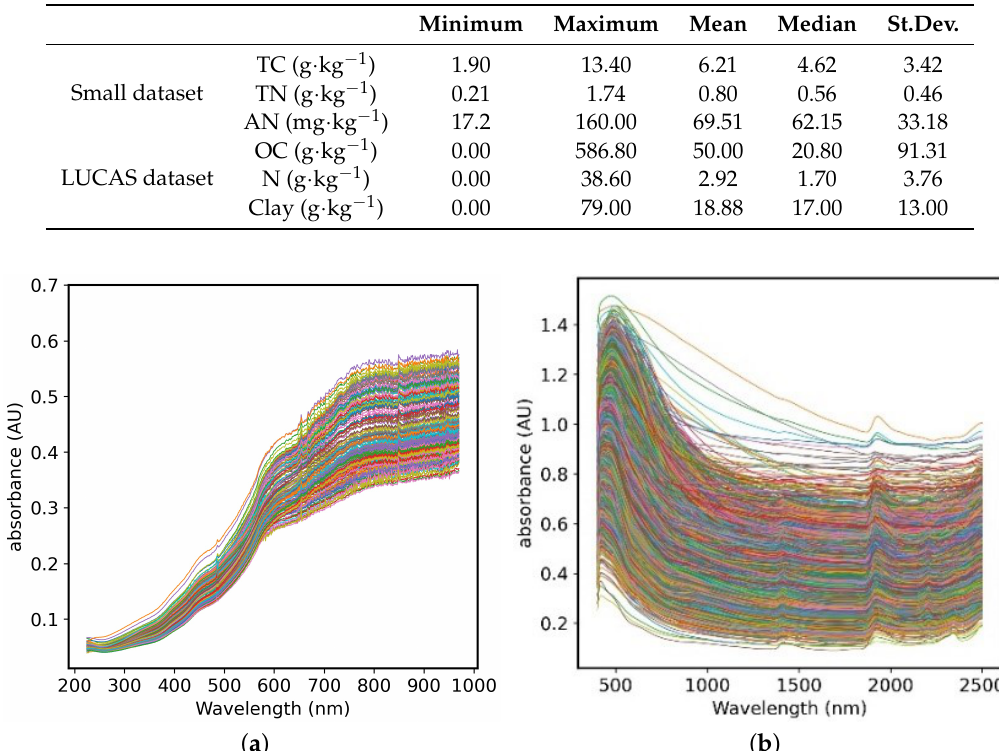
Table 1. Basic information of soil data set.